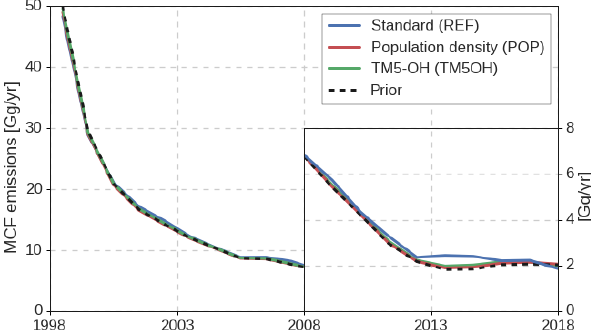
Figure 3. Time series of annual global total MCF emissions, de- rived in the three different inversion setups (solid lines) and the prior emissions (black dashed). To visualize variations in the low emissions in later years, we provide emissions in the second decade on a different y scale (right